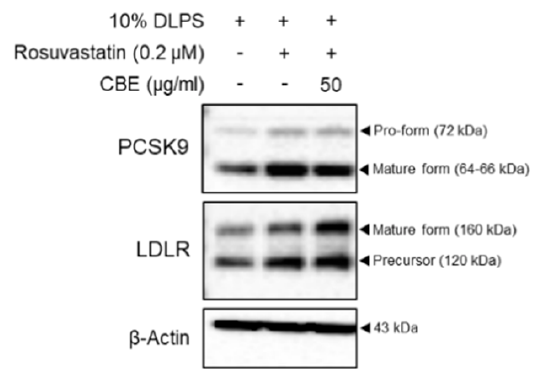
Figure 2. PCSK9 and LDLR protein expression in HepG2 cells treated with DLPS and rosuvastatin (0.2 µM) and mevalonate (50 µM) in the presence or absence of CBE (50 µg/mL), as measured by Western blot.